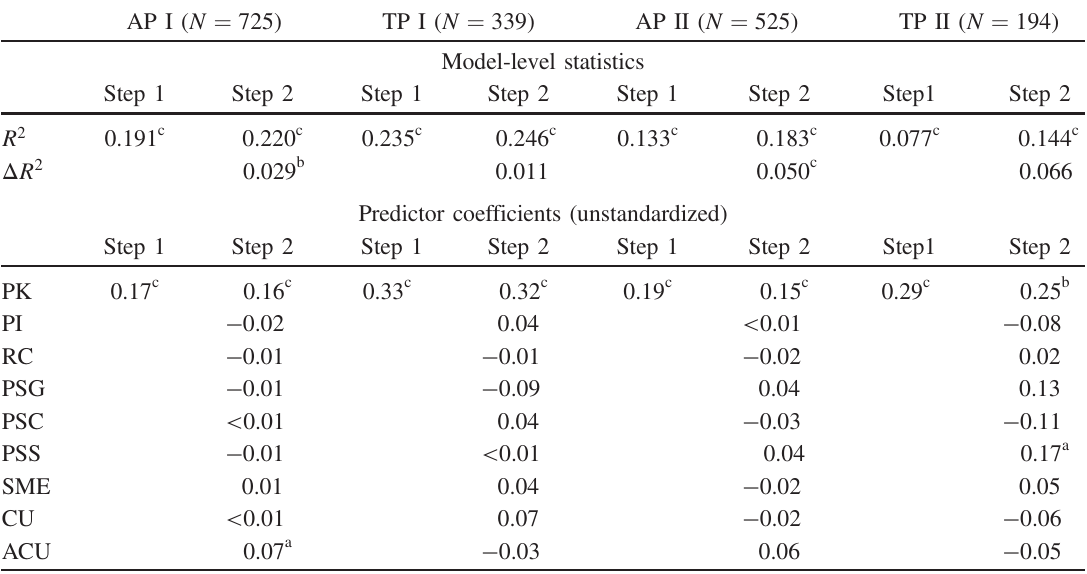
TABLE V. Regression-Model Summaries predicting exam scores from prior knowledge measures and eight CLASS categories Fall Active Physics (AP I); Fall Traditional Physics (TP I); Spring Active Physics (AP II); Spring Traditional Physics (TP II); number of observations ( N ); change in R 2 between step 1 and step 2 ( Δ R 2 ); prior knowledge (PK) (FCI in AP I and TP I, BEMA in AP II and TP II); personal interest (PI); real- world connection (RC); problem-solving general (PSG); problem-solving confidence (PSC); problem-solving sophistication (PSS); sense-making effort (SME); conceptual understanding (CU); applied conceptual understanding (ACU). Prior knowledge alone was entered in step 1 of each model, and the eight CLASS variables were added in step 2.